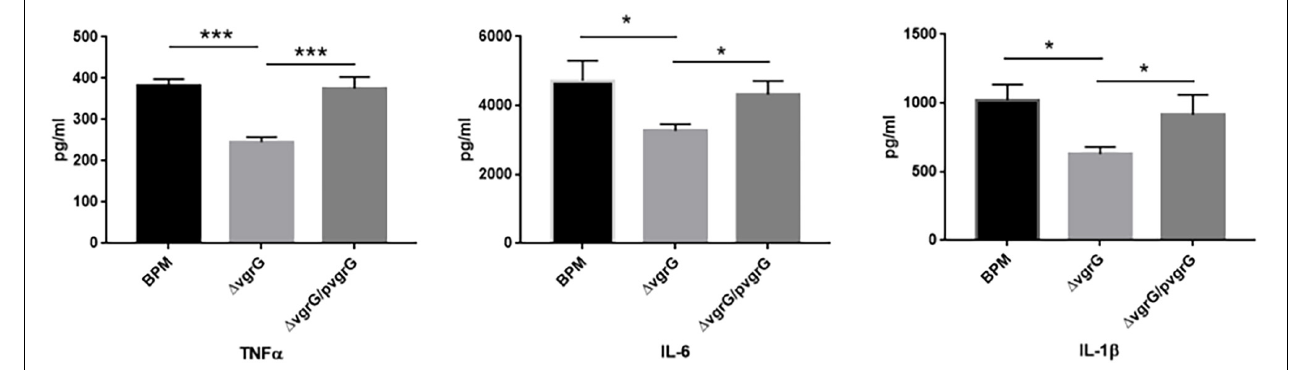
FIGURE 4 | Serum levels of cytokines in BLAB/c mice 16 h after infection with BPM, mutant and complemented strains. Serum IL-1 β , IL-6, and TNF- α levels in BALB/c mice 16 h after infection with the BPM, mutant and complement strains. All data are from three independent experiments. Significant differences between groups are indicated: *( P < 0.05) and ***( P < 0.001).